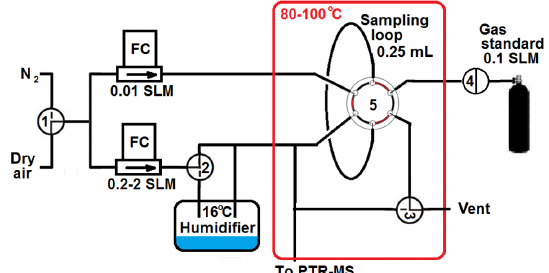
Figure 1. Schematic of the semi-automated calibration unit. Manual three-way valves allow selection of dry air or nitrogen as carrier gas (valve 1), dry or humidified carrier gas (valve 2), and sample loop injections or dynamic mixing of carrier gas and gas standard (valve 3). Valve 4 (PFA solenoid) and valve 5 (Valco 6 port with Restek Sulfinert ® coating) are controlled to provide a sequence of 10 injections in